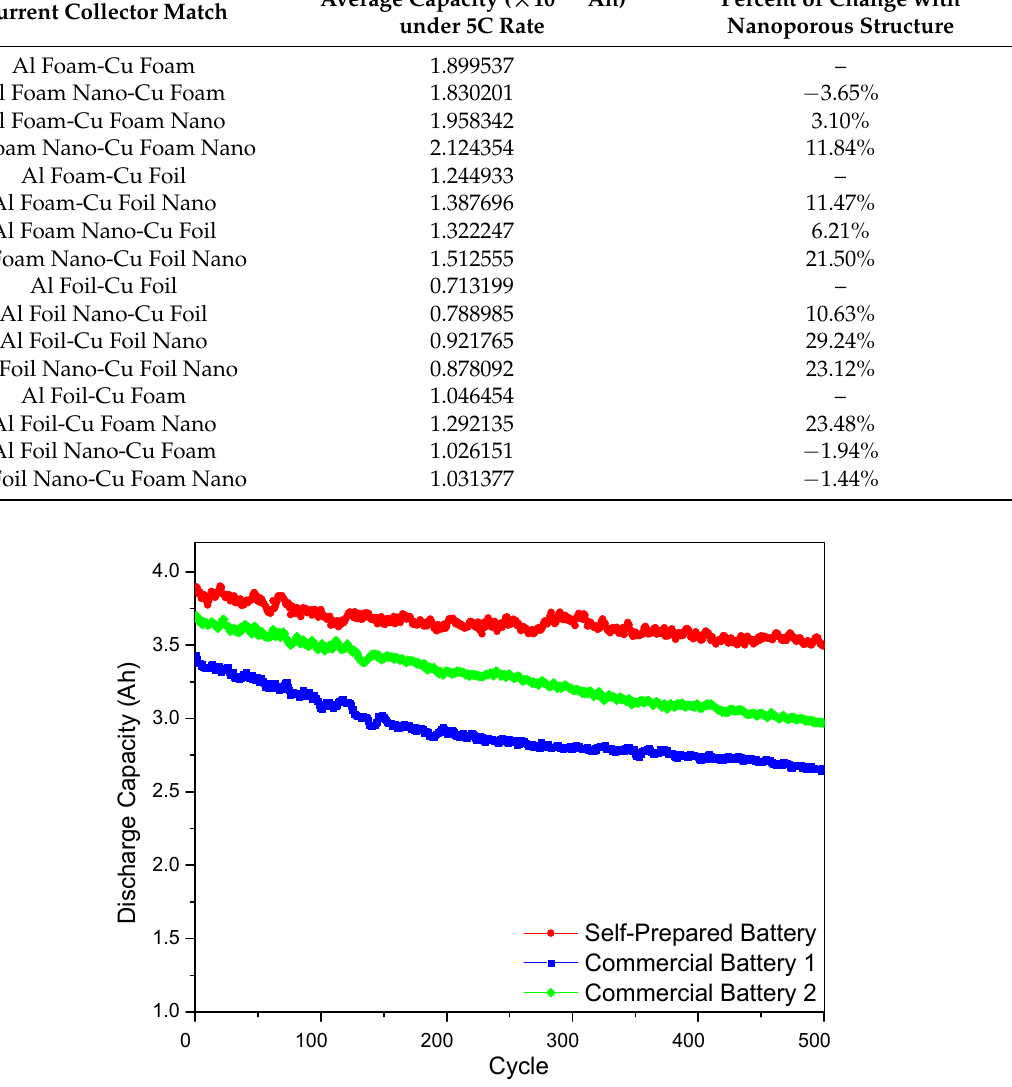
Figure 6. Long-term cycling performance of a self-prepared lithium ion battery in comparison to two commercial Figure 6. Long ‐ term cycling performance of a self ‐ prepared lithium ion battery in comparison to two commercial batteries.